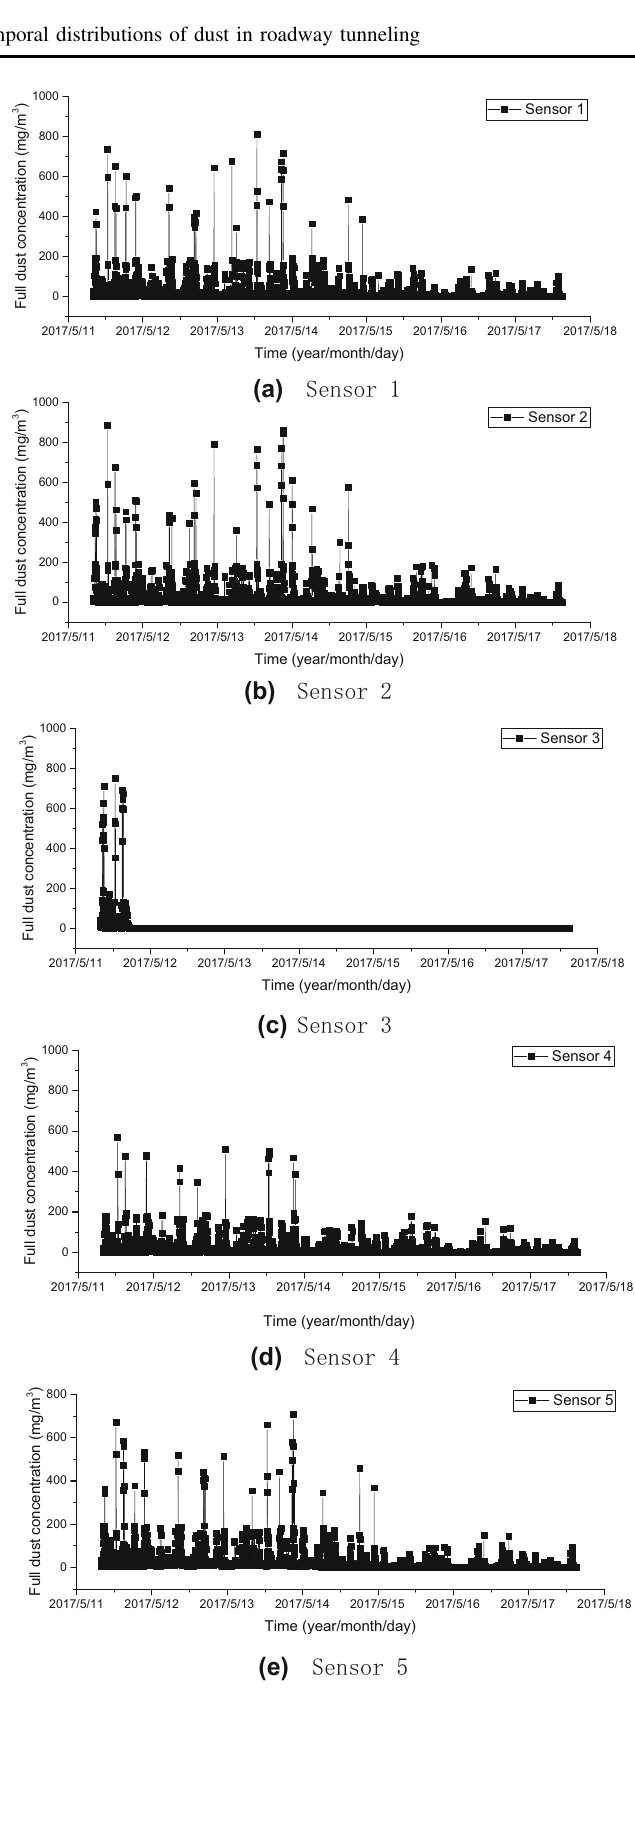
(a) (cid:54)(cid:72)(cid:81)(cid:86)(cid:82)(cid:85)(cid:3)(cid:20)